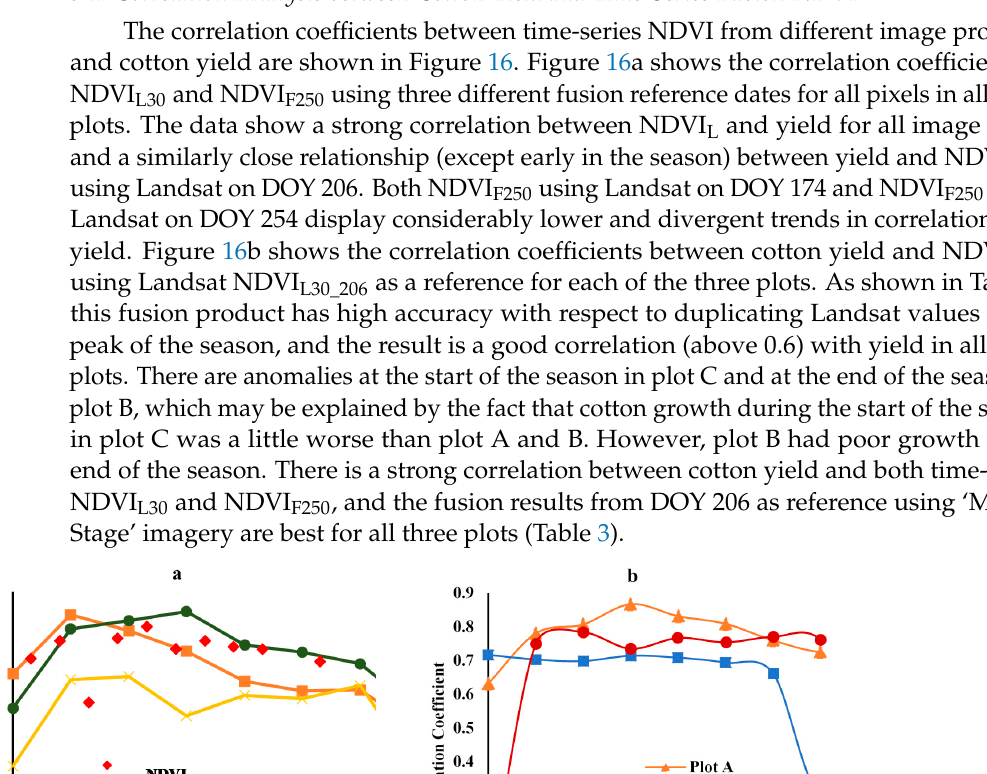
Figure 16. Correlation coefficients between NDVI L30 , NDVI F250 fused with 3 dates of Landsat (DOY174, 206, 254) and cotton yield ( a ) correlation coefficient results from NDVI F250 for three plots; ( b ) correlation coefficient results from MOD13Q1 and Landsat NDVI L30_206 of three plots.